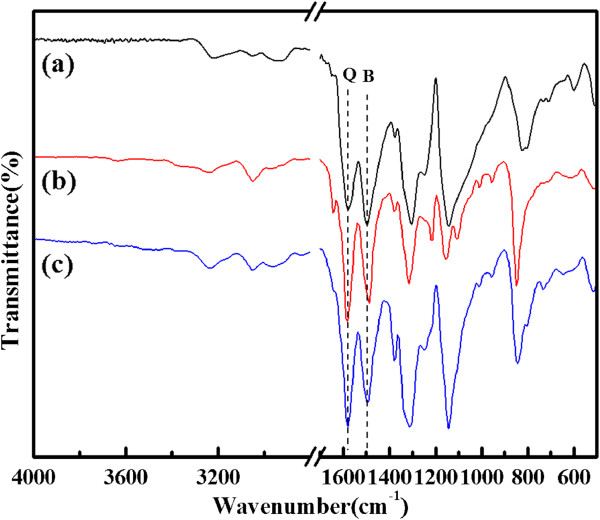
FTIR spectra. Curves (a) PANI, (b) PANI(HAuCl4·4H2O), and (c) PANI(H2PtCl6·6H2O).